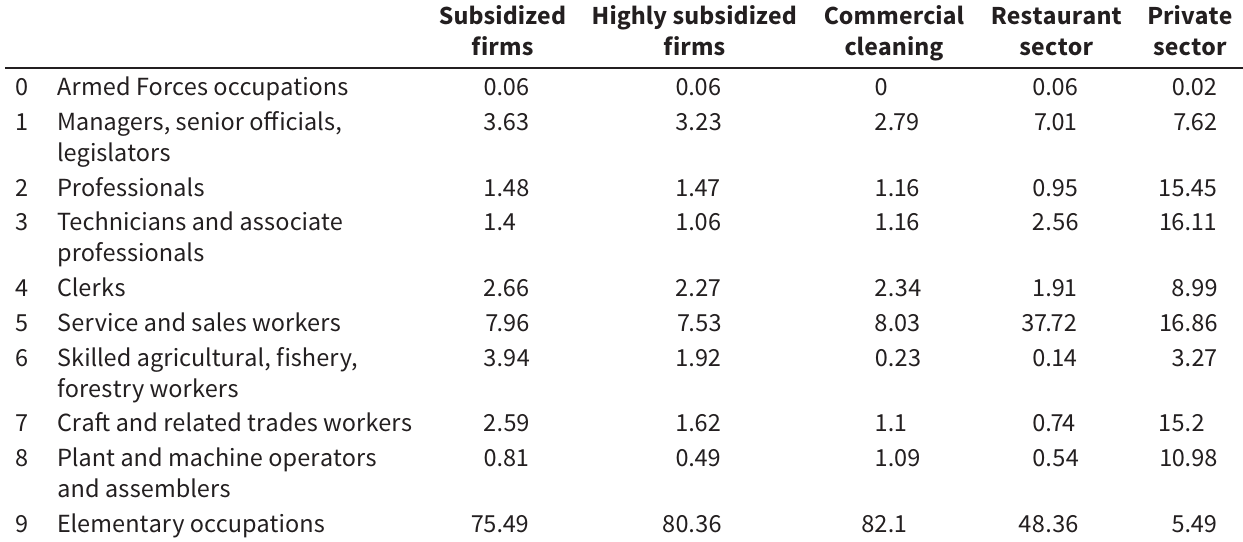
Distribution of 1-digit occupations across sectors (%)